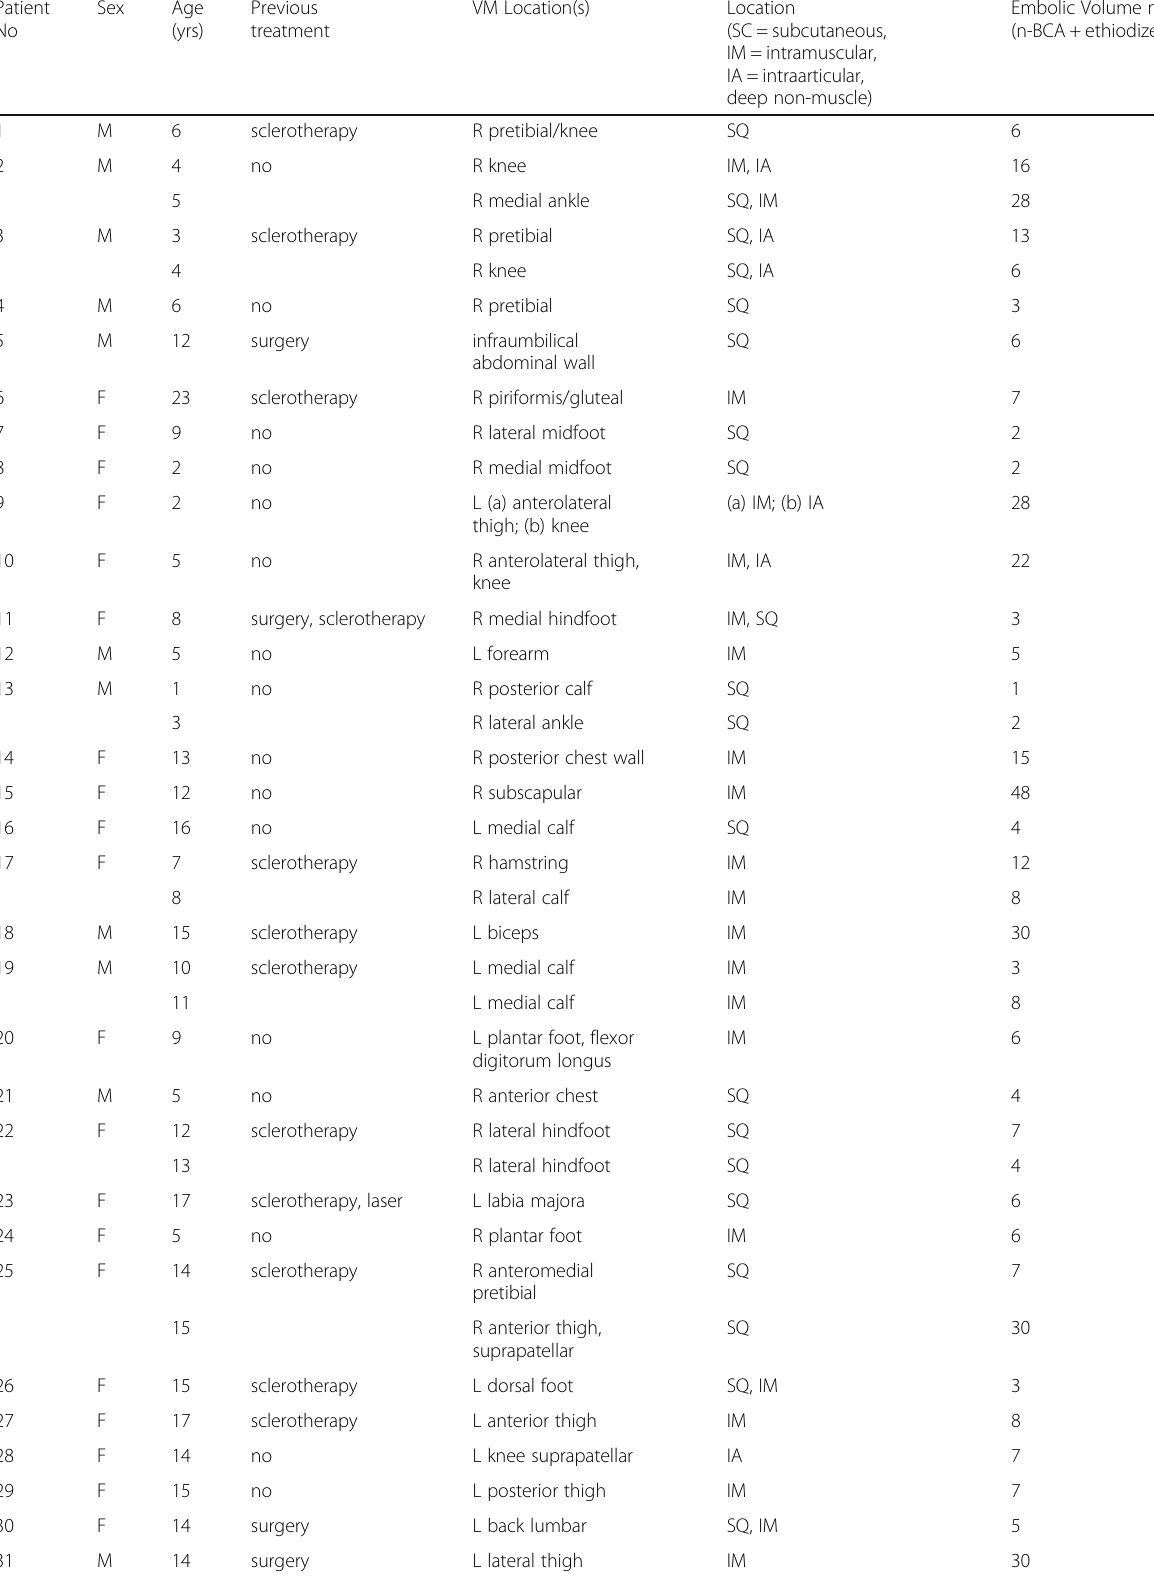
Table 1 Patient demographics, treated lesion characteristics, and embolic material volumes Patient